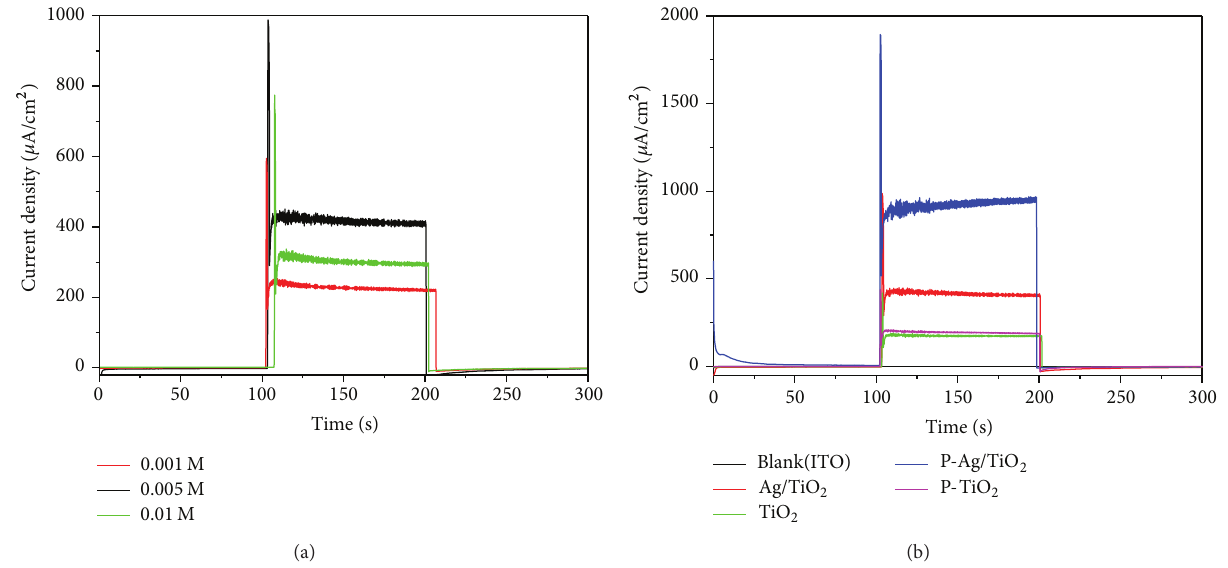
Figure 7: Photocurrent profile of (a) different concentrations of Ag + on TiO 2 and (b) ITO, TiO 2 , Ag/TiO 2 , P-TiO 2 , and P-Ag/TiO 2 .